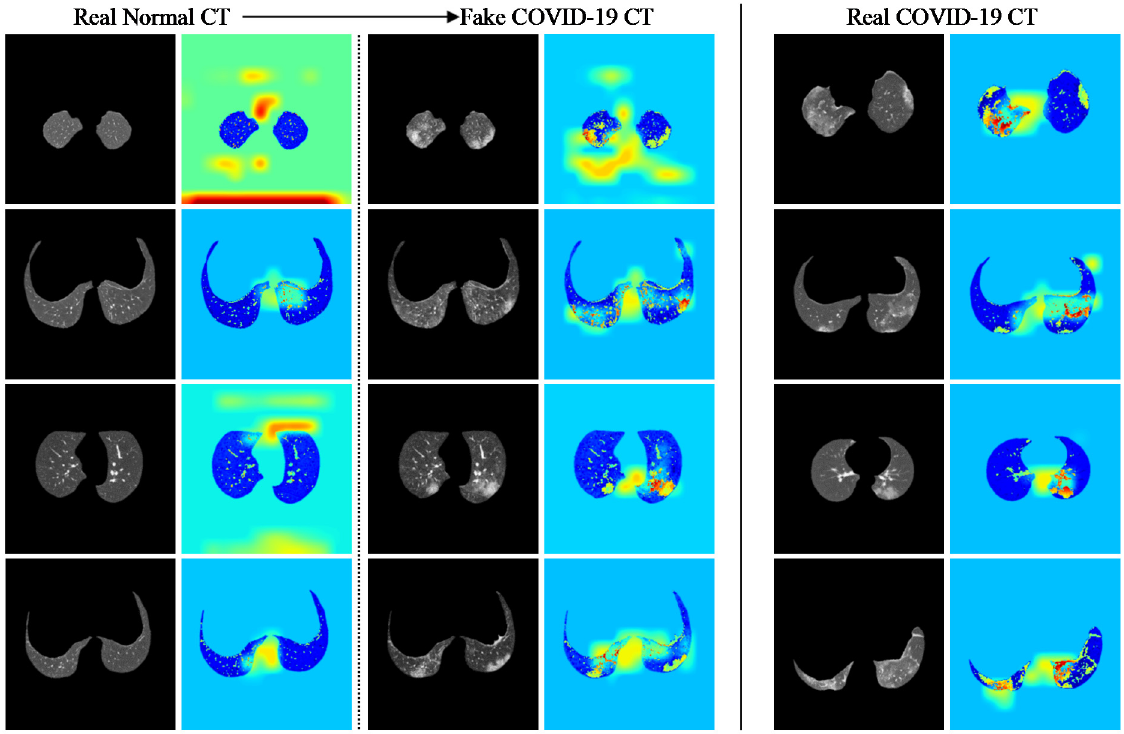
Figure 16. Grad-CAM of a pre-trained COVID-19 detection model on real non-COVID-19, real COVID- Figure 16. Grad‑CAM of a pre‑trained COVID‑19 detection model on real non‑COVID‑19, real 19, and synthetic COVID-19 CT images. COVID‑19, and synthetic COVID‑19 CT